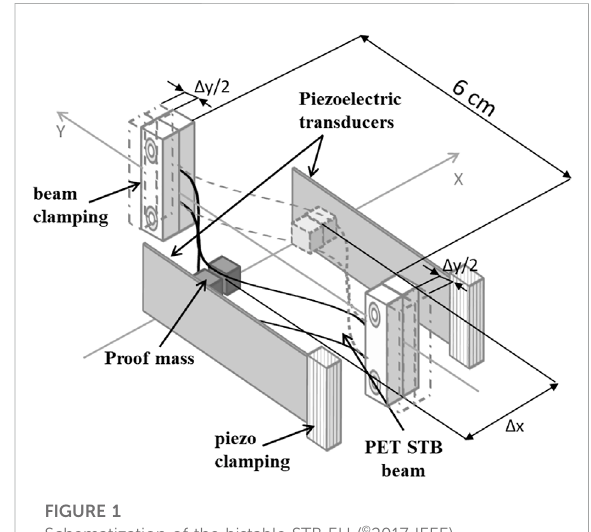
FIGURE 1 Schematization of the bistable STB EH ( © 2017